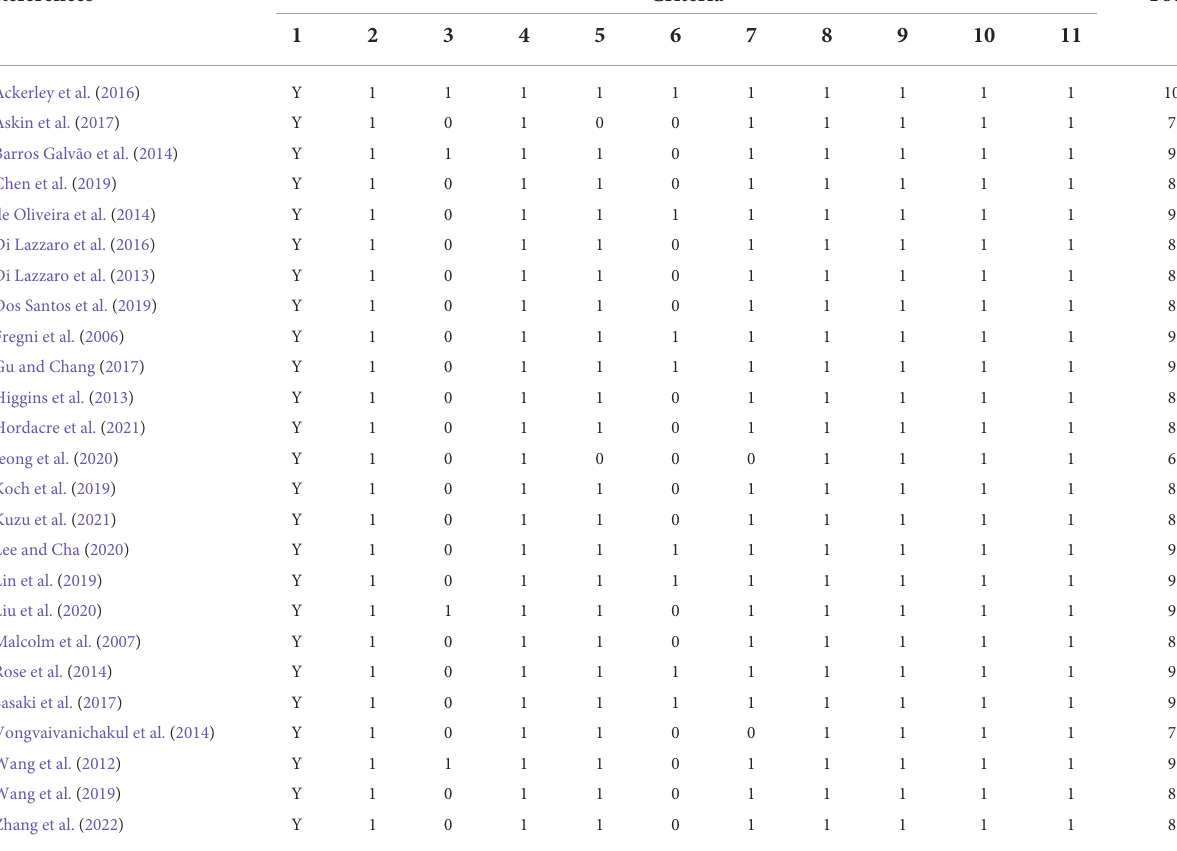
TABLE 1 Assessment of risk of bias in the included